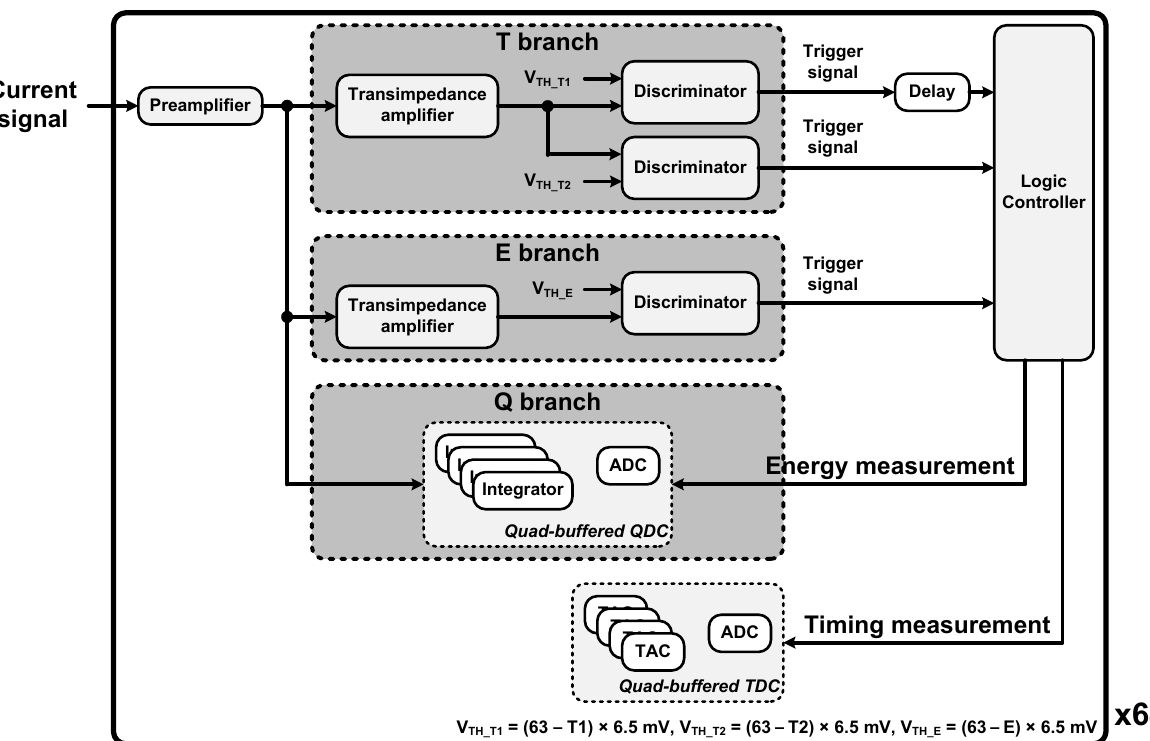
Figure 4. Block diagram of TOFPET2 ASIC in QDC mode.